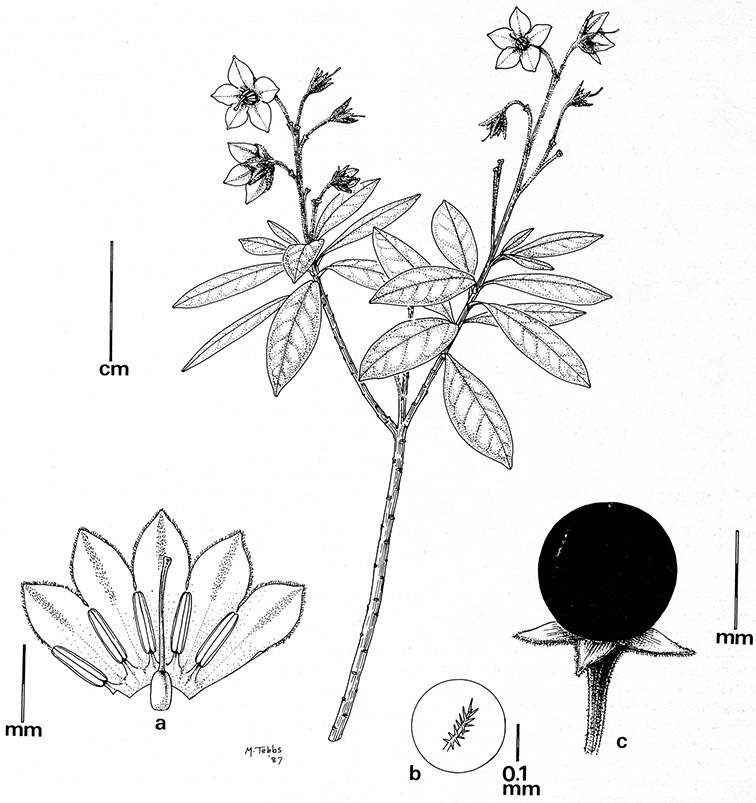
Solanum imbaburense S. Knapp. (A–C drawn from Øllgaard & Balslev 8567). Reproduced from Knapp (1989) with permission of the Natural History Museum Botany Library. Illustration by Margaret Tebbs.